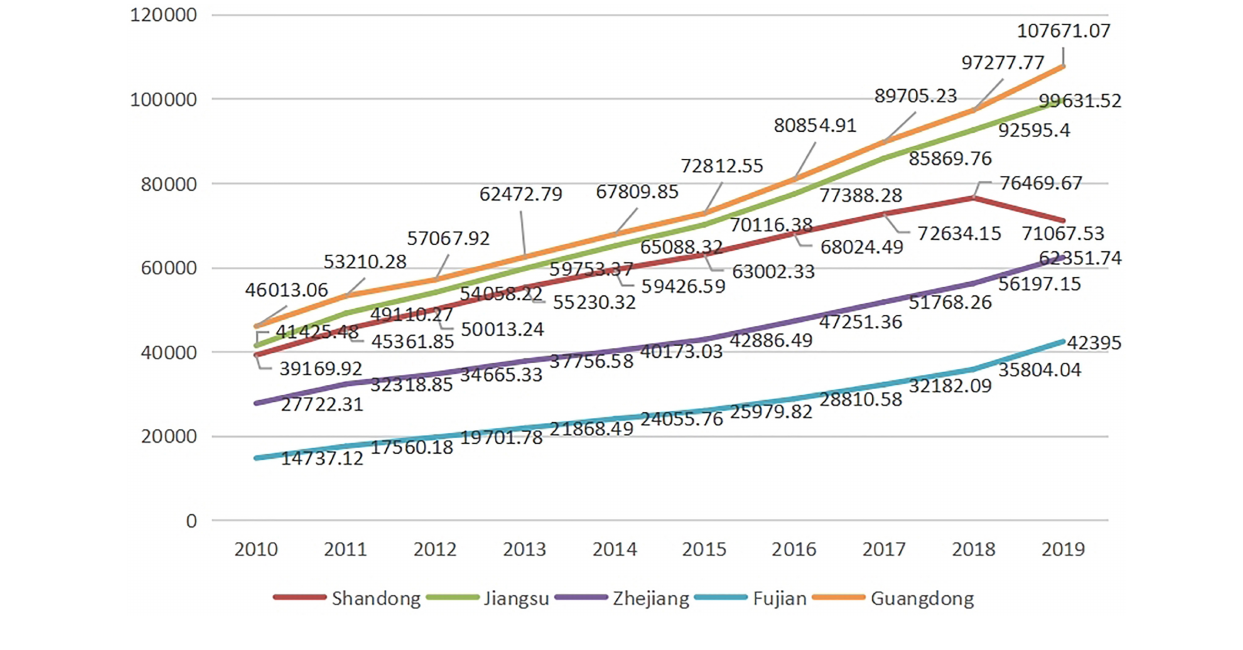
FIGURE 2 | Trends of GDP in the five provinces (2010 − 2019).